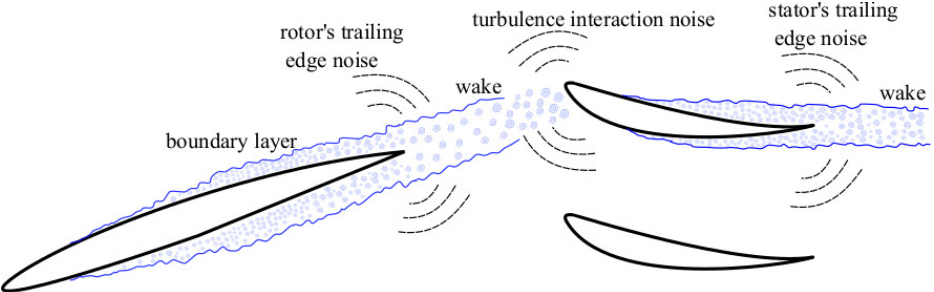
Figure 1. Schematic of trailing edge noise and interaction noise mechanisms for a fan/OGV stage. The TIN results from a direct impingement of the rotor turbulent wakes on the stator leading edge. Turbulence coming from the rotor induces load fluctuations on the vanes, which produces broadband